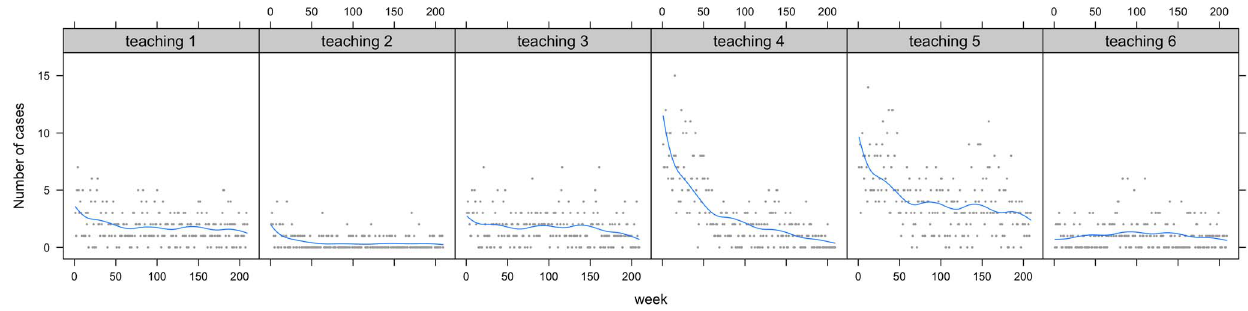
Figure 4. AR(1) model fit teaching hospitals. Grey dots represent the weekly-observed CDI cases within the teaching hospitals from April 2008 to March 2012. X-axis: Week 0 corresponds to the first week of April 2008 and week 209 to the last week of March 2012. Blue line: fit of the AR(1) model with a cubic representation of the rate of change of CDI over time and seasonality.